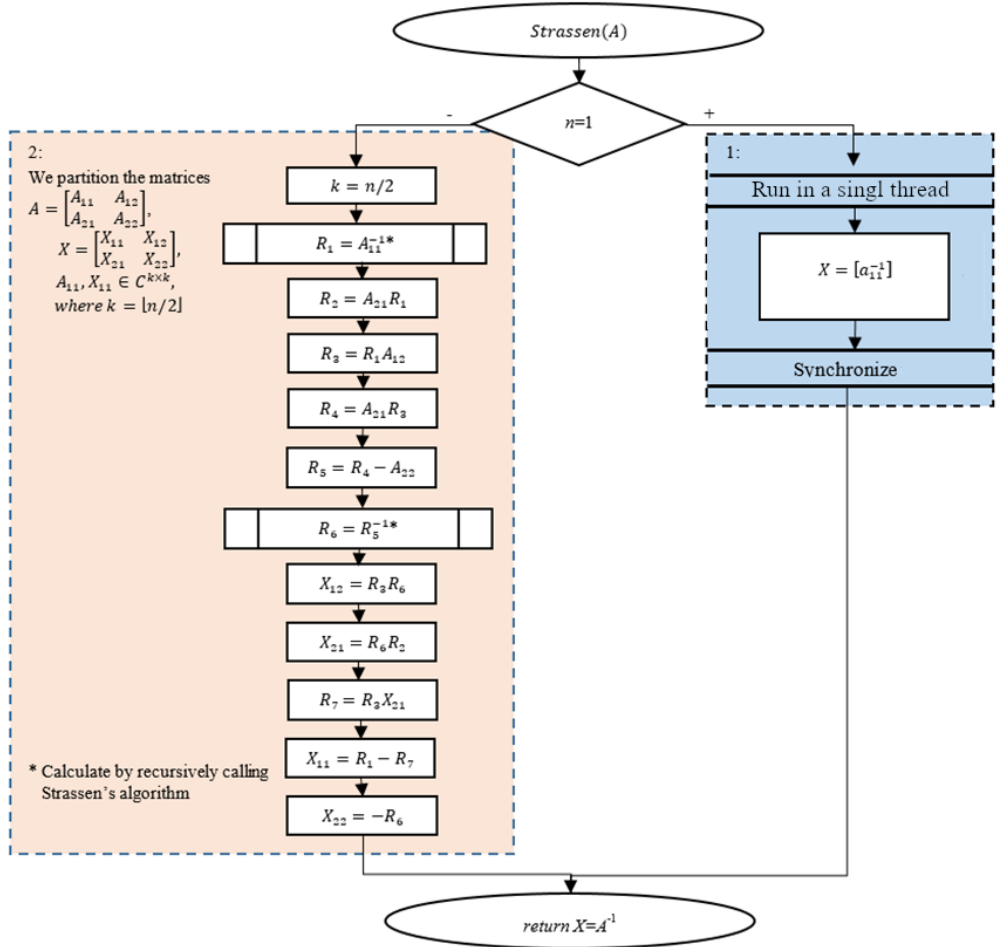
Figure 6. Step 1 of Strassen’s matrix inverse algorithm: CUDA version.